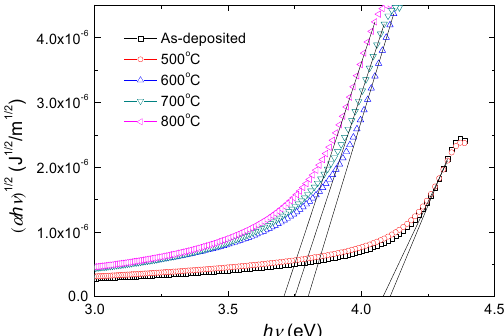
Figure 7. The ( α h ν ) 1/2 vs. h ν for the SrTiO 3 films annealed at different Figure 7. The (𝛼ℎ𝜈) (cid:2869)/(cid:2870) vs. ℎ𝜈 for the SrTiO 3 films annealed at different temperatures. Table 2. Main parameters ( 𝜀(∞) , 𝐴 (cid:3036) and 𝐸 (cid:3036) ) of the Lorentz oscillator model and the calculated band gap 𝐸 (cid:3034) for SrTiO 3 thin films annealed at different temperatures.